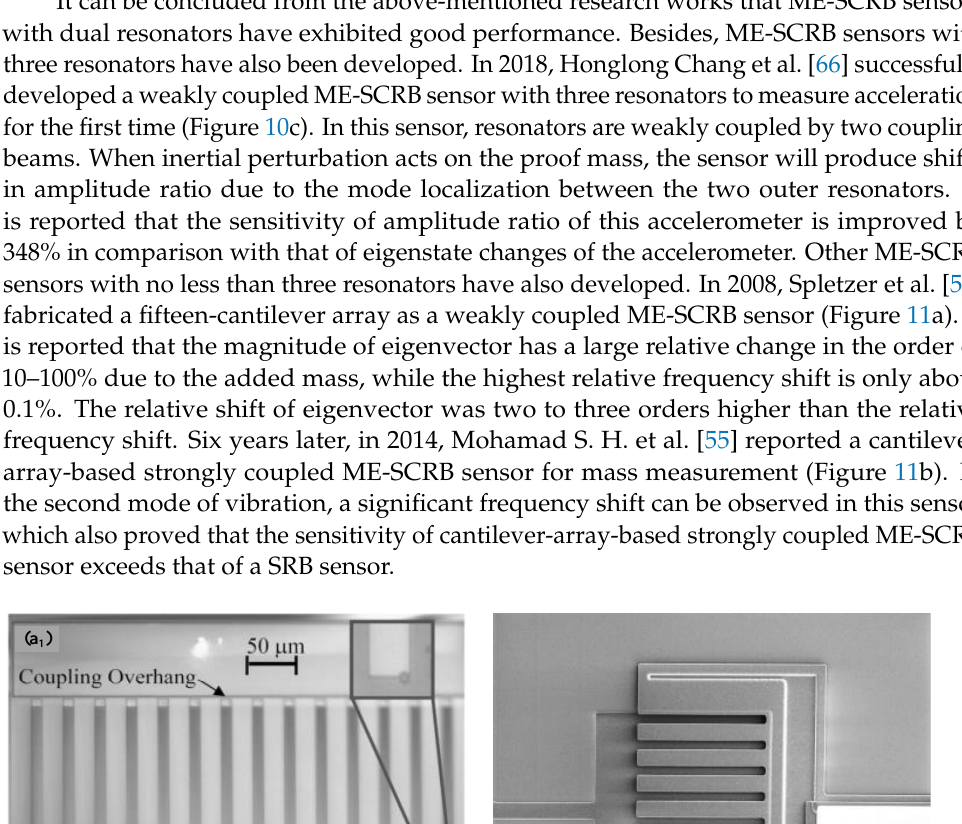
Table 2. Comparisons of properties of different ME-SCRB sensors.